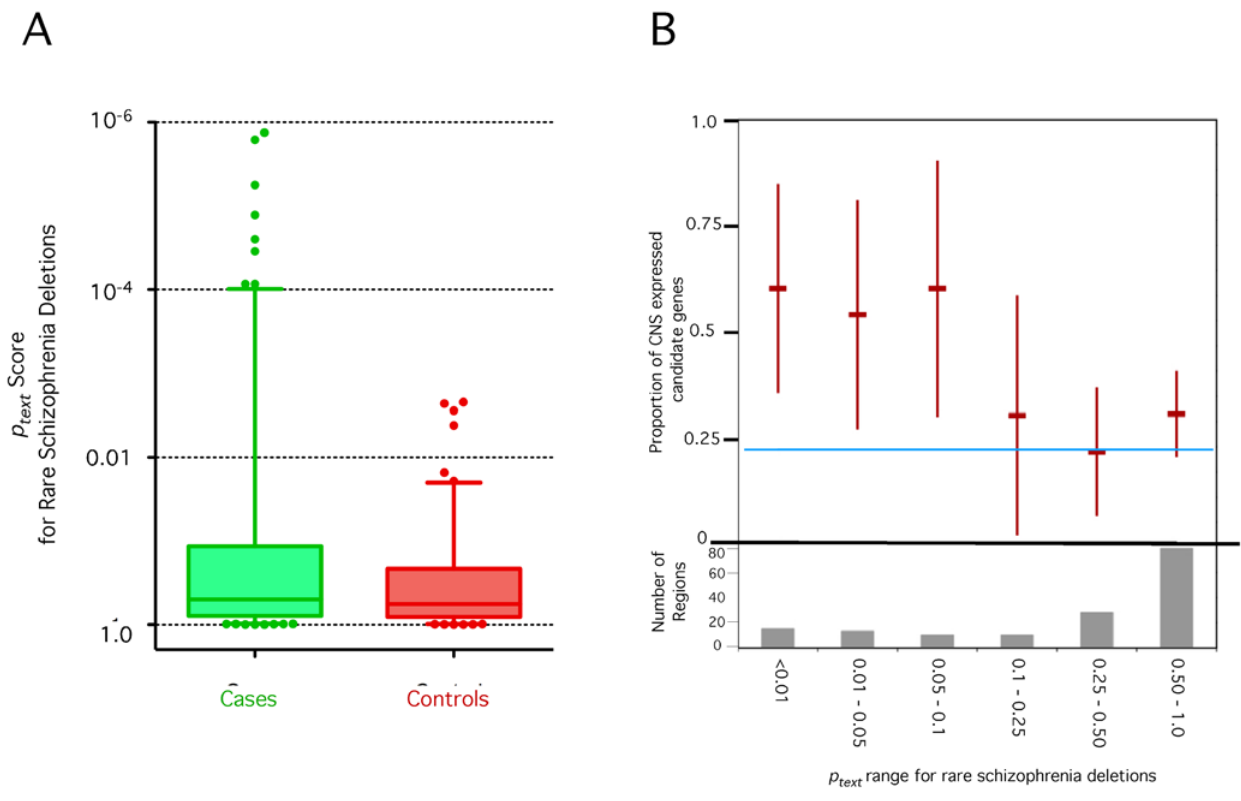
Figure 4. GRAIL identifies a subset of highly connected genes within rare deletions found in Schizophrenia cases. (A) Case deletions versus control deletions. Here we plot the results of the separate GRAIL analyses conducted on the deletions observed in schizophrenia cases and controls. Case deletion p text scores are displayed in red; control deletion p text scores are displayed in green. The line in each category in the middle of the box represents the median GRAIL p text score. The box represents the 25–75% range. The bars represent the 5–95% range. Additional scores outside the range are individual plotted. (B) Text-based GRAIL significance score tracks with CNS specific expression. We partition case-only deletions by their GRAIL scores. For each range of GRAIL p text scores, we assess the candidate genes selected by GRAIL for CNS expression. The upper portion of this plot illustrates the fraction of those candidate genes that demonstrate preferential CNS expression along with 95% confidence intervals. The blue line represents the total fraction of genes that are preferentially CNS expressed. For the most compelling GRAIL scores, the candidate genes are significantly enriched for CNS expression compared to what would be expected from a random group of genes. The lower portion of the plot is a histogram.